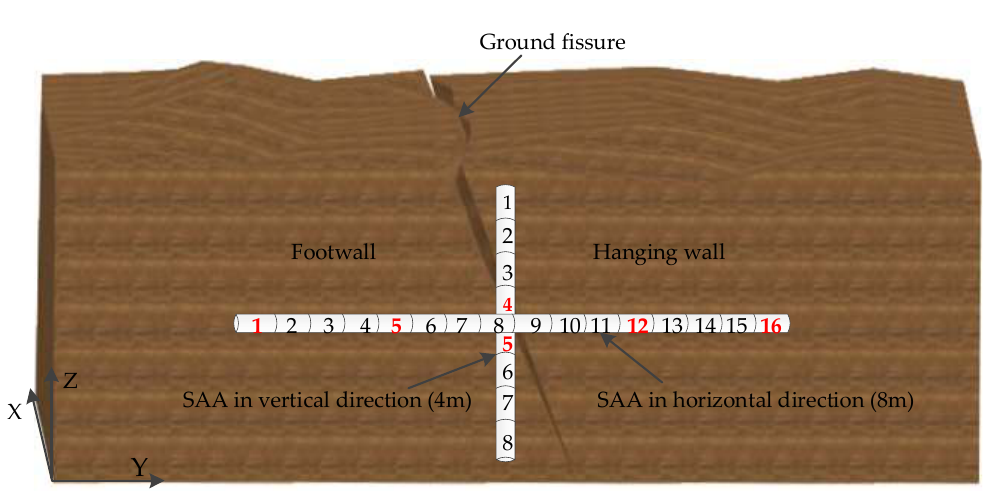
Figure 3. Layout of the SAA sensors at the Xiwang Road ground fissure.